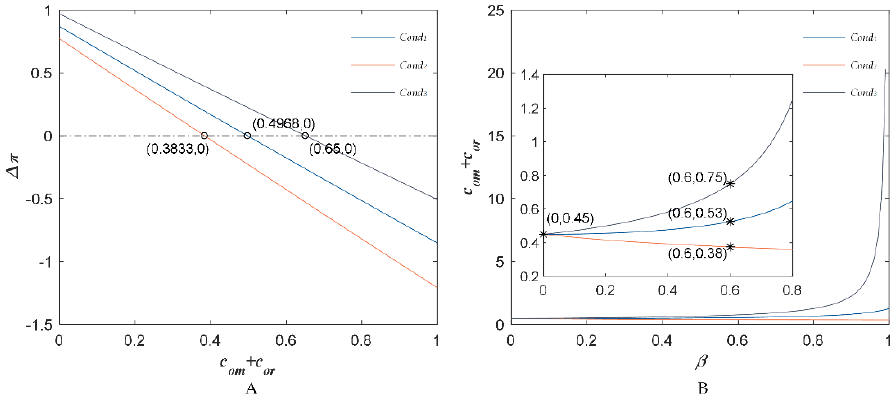
Figure 7. The relationship between total cost and profit ( A ), the sensitivity coefficient of competitive agricultural product price ( B ).